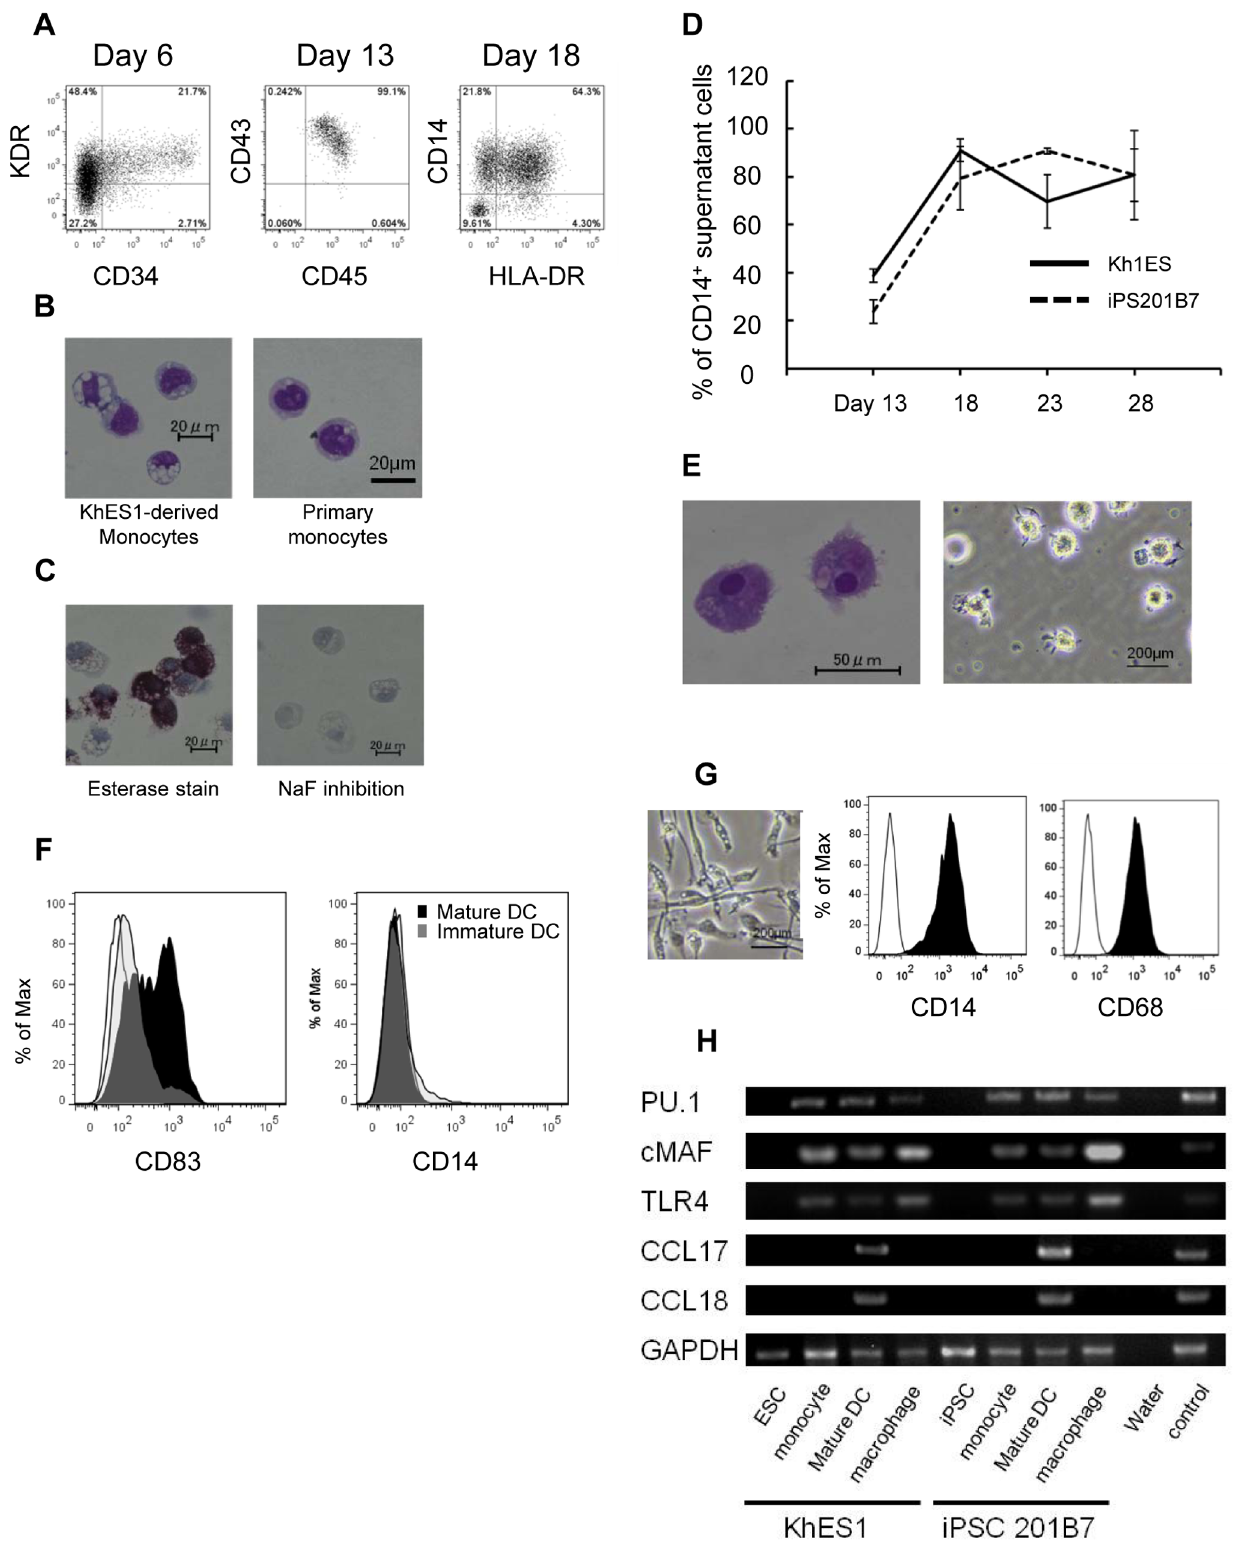
Figure 2. Phenotype analysis and gene expression pattern of monocytic lineage cells derived from pluripotent stem cells. (A) Flow cytometric analysis of monocytic lineage cells derived sequentially from pluripotent stem cells. An analysis of adherent cells on day 6 and supernatant cells on day 13 and 18 is shown. (B) May-Giemsa staining of CD14 + monocyte-like cells derived from KhES1 on day 16 (left) and primary human monocytes (right). (C) Esterase staining for CD14 + monocyte-like cells derived from KhES1 on day 16. (D) The percentage of CD14 + cells within the total floating cells derived from KhES1/iPS-201B7 was evaluated from day 13 to day 28. (E) May-Giemsa staining (left) and phase contrast image (right)